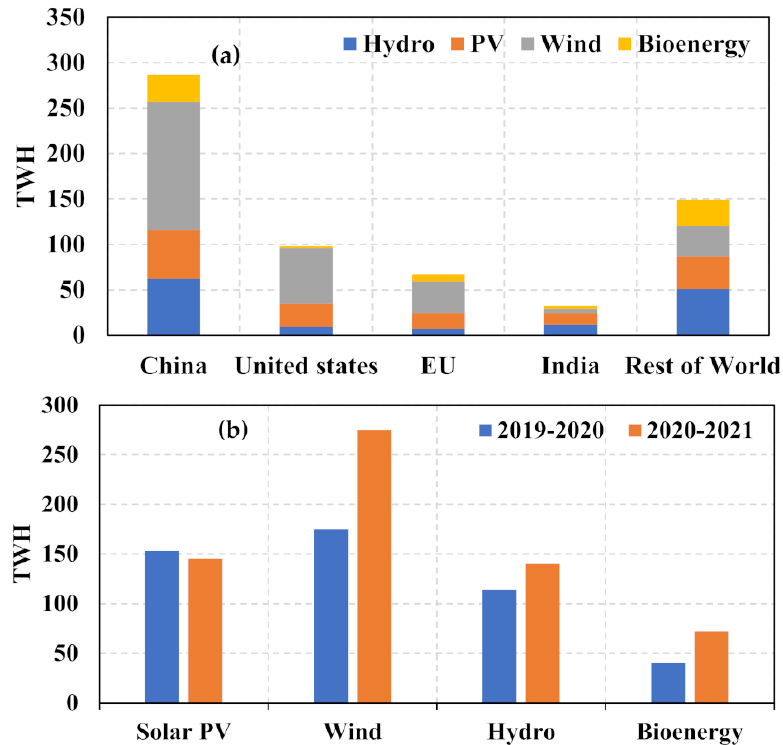
Figure 1. RESs’ production growth by ( a ) RESs types and country in 2020–2021, and ( b ) types